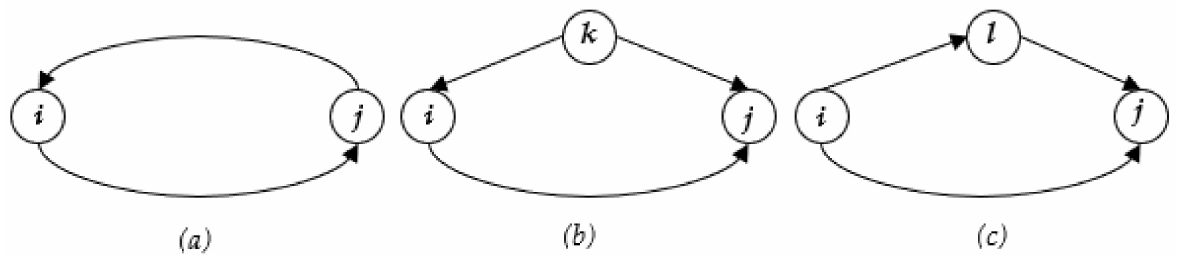
Figure 5. Three possible cases of influence of variable i on variable j according to the structural analysis of impacts: ( a )—direct impact; ( b , c )—indirect